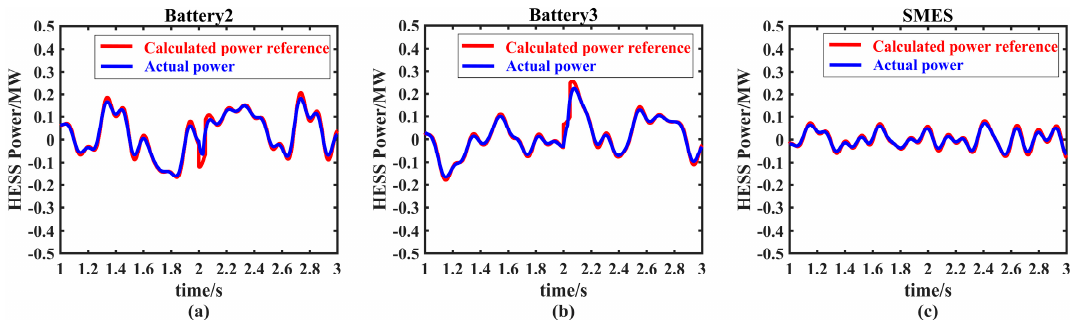
Figure 14. Calculated and actual power of the MMCs. (a) MMC1; (b) MMC2; (c) MMC3.